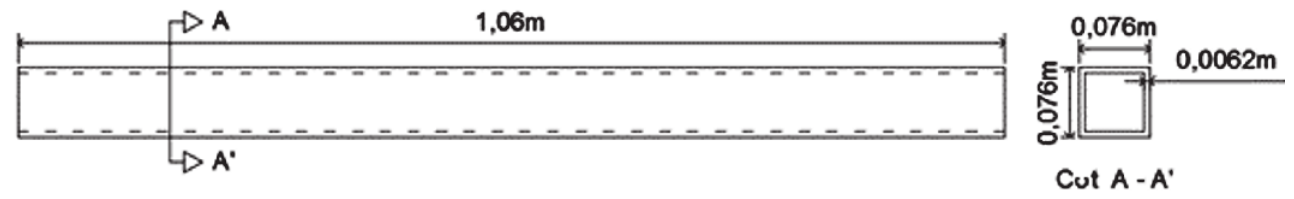
Figure 6 Longitudinal view and cross section of the GFRP profile of the reduced model (Author)